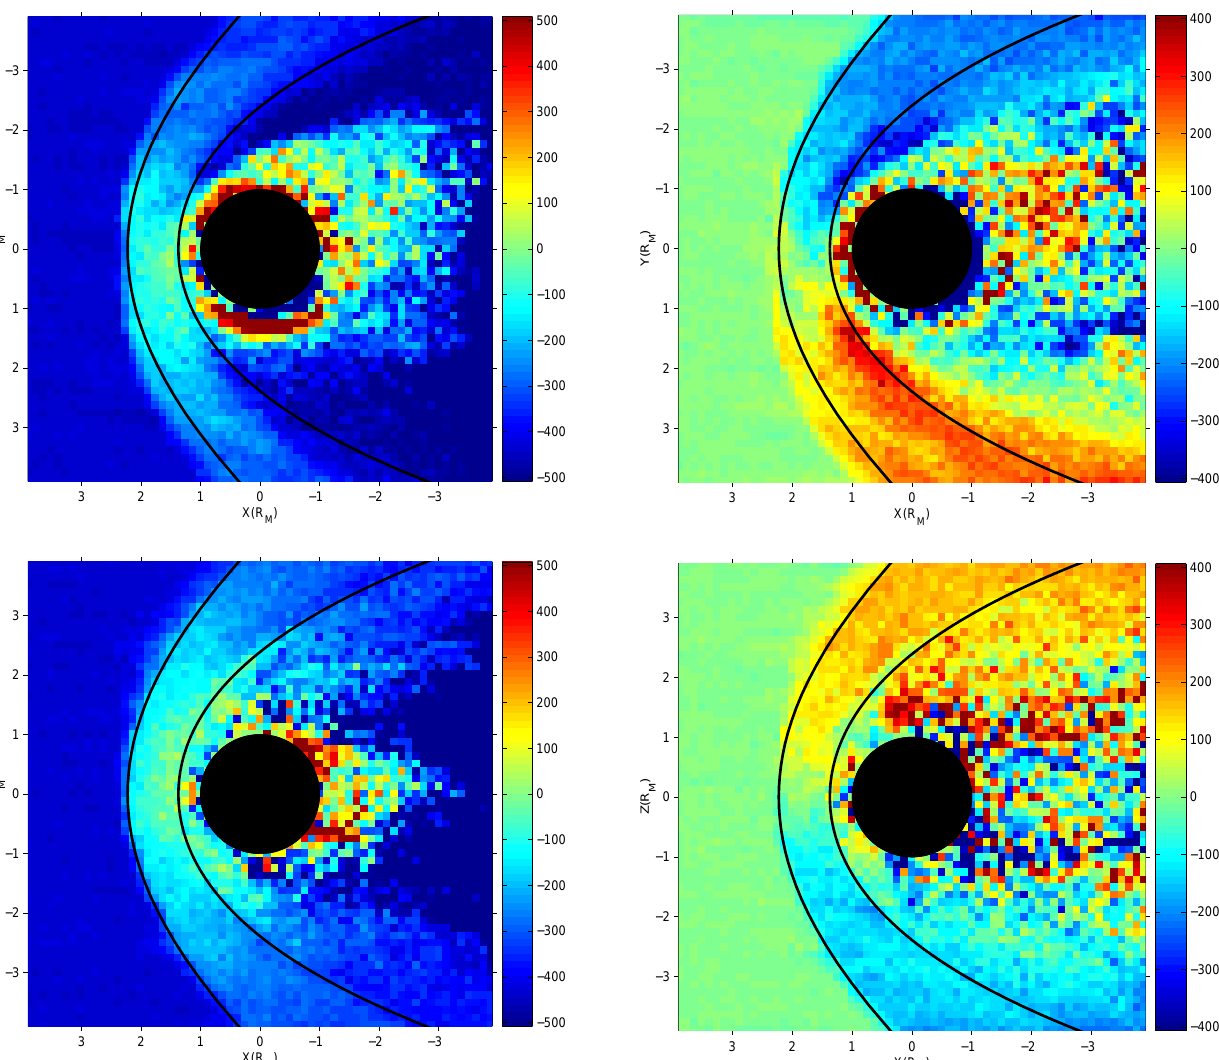
Fig. 5. The velocity of the solar wind protons along the x -axis, U x (H + ), on (top) the XY plane and on (bottom) the XZ -plane in kms − 1 .